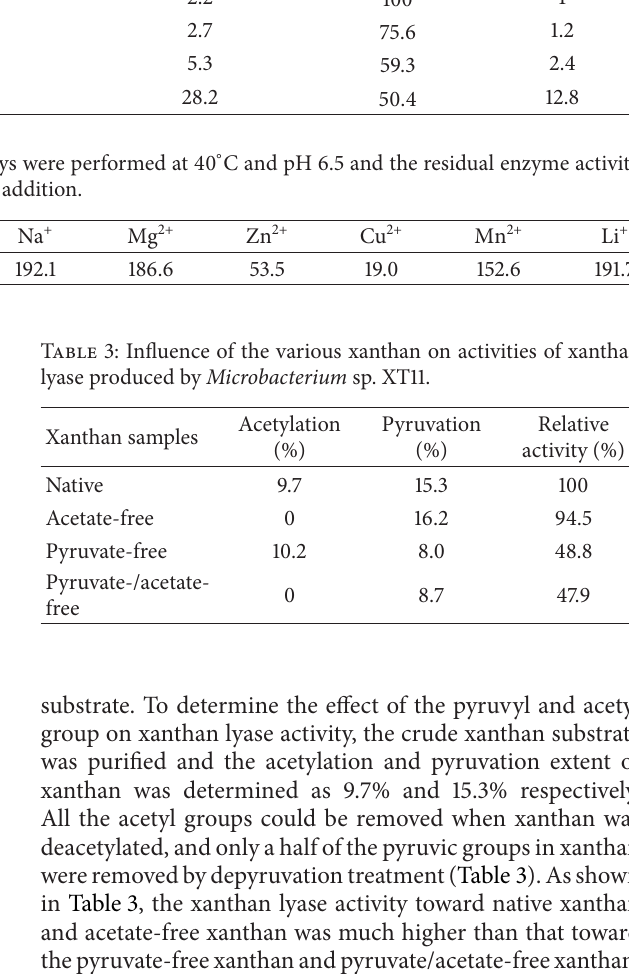
Table 1: Purification of xanthan lyase from the xanthan-grown culture of Microbacterium sp. XT11. Purification steps